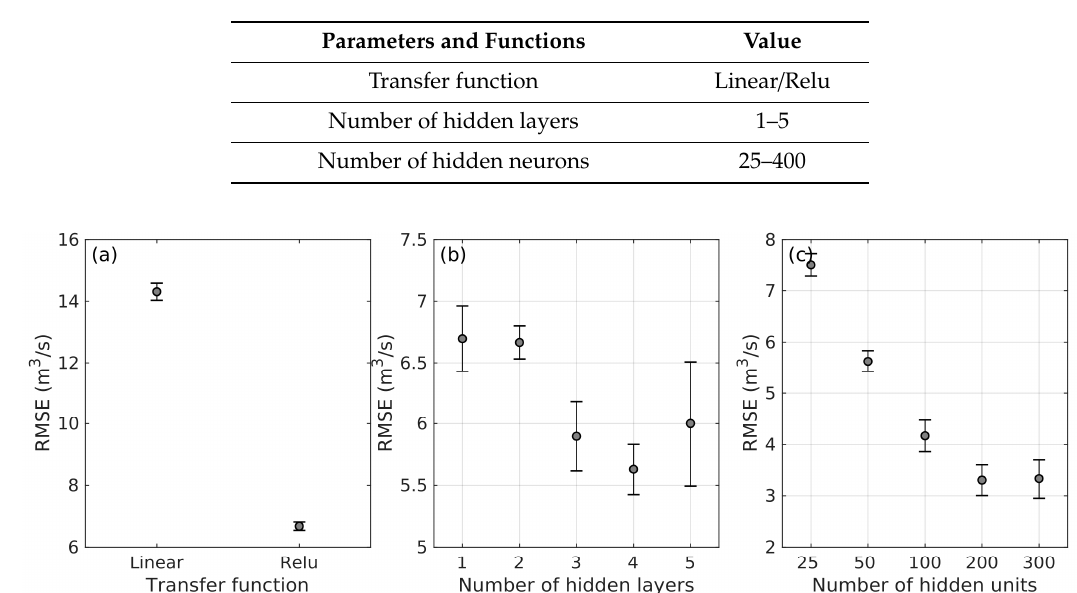
Figure 6. Root mean square error (RMSE) of a Maipo en el Manzano validation subset as a function of: ( a ) Transfer function for the ANN model, ( b ) the number of hidden layers, ( c ) the number of hidden units.